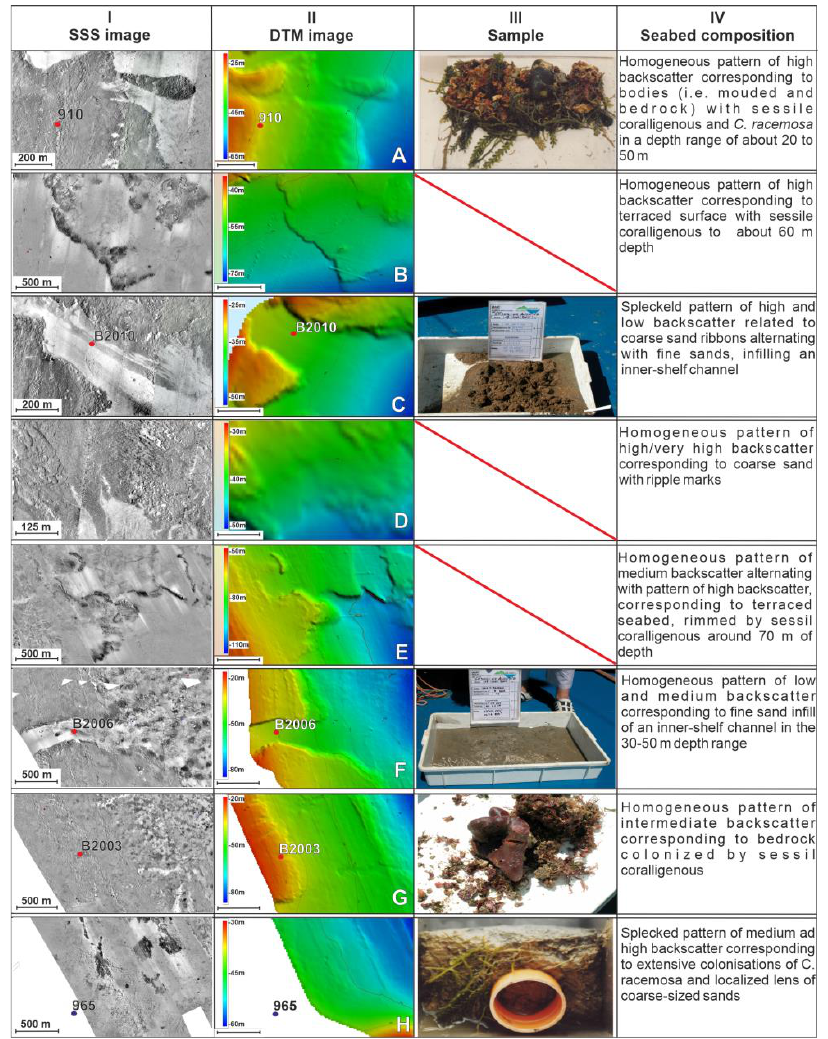
Figure 6. Side-Scan Sonar mosaic on the continental shelf of Augusta Bay (localization of zoomed images is in Figure 2), in areas seemingly free from physical damage ( I column); DEM of the seabed ( II column); seabed samples serve to calibrate acoustic images ( III column); description of the acous- tic facies and possible interpretation ( IV column).